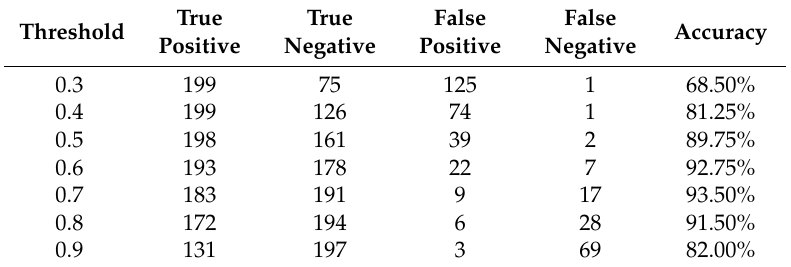
Table 2. Table of 3D model identification results with default settings and different thresholds.